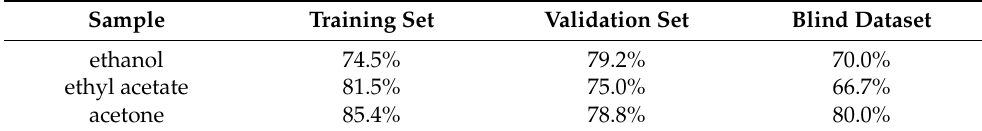
Table 4. Performance of PCA and the